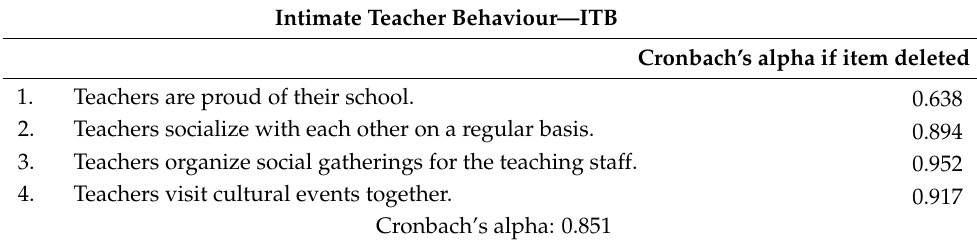
Table 7. Intimate teacher behaviour ITB—Cronbach’s alpha for internal consistency.